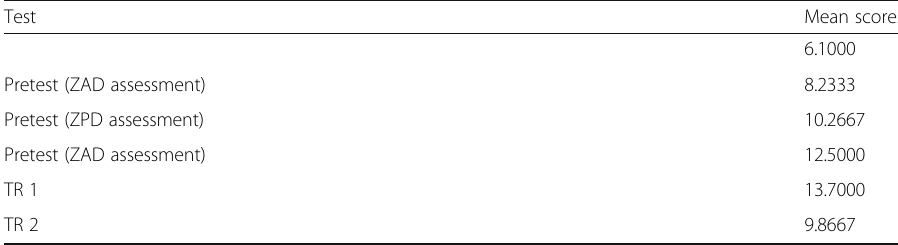
Table 19 Mean Scores of the Experimental Group across Assessment Sessions